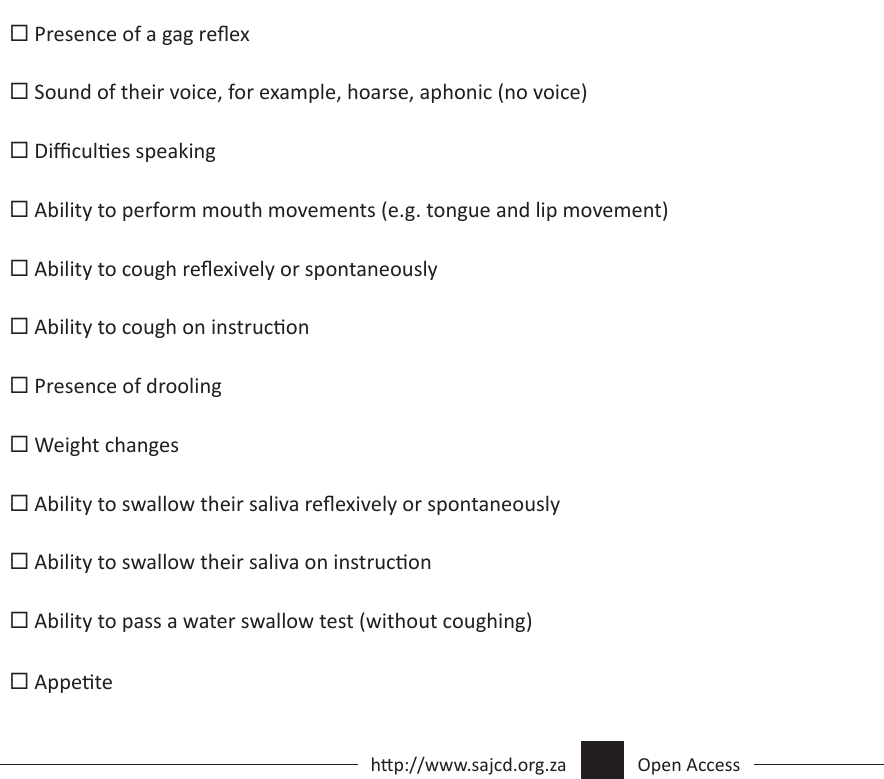
Section 1: Identification of dysphagia refers to the formal screening and/or informal observation of dysphagia signs and